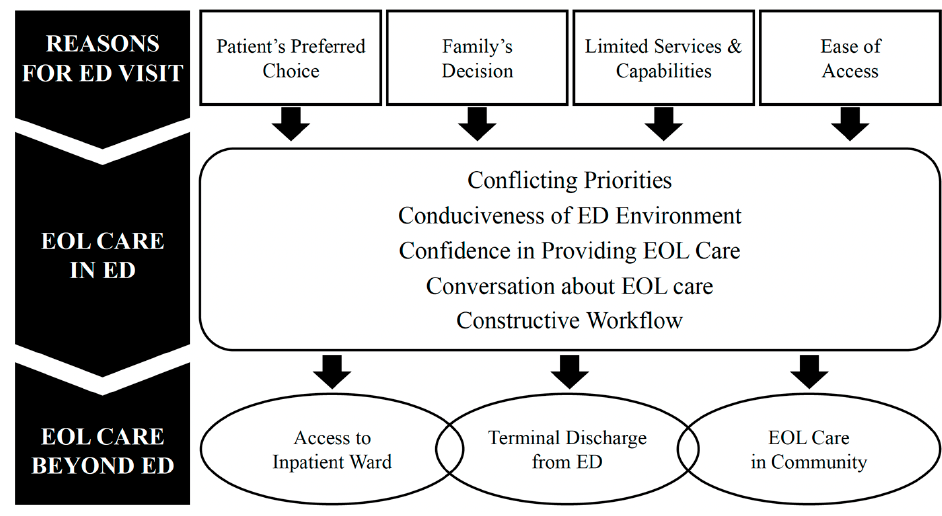
Figure 3. Themes and